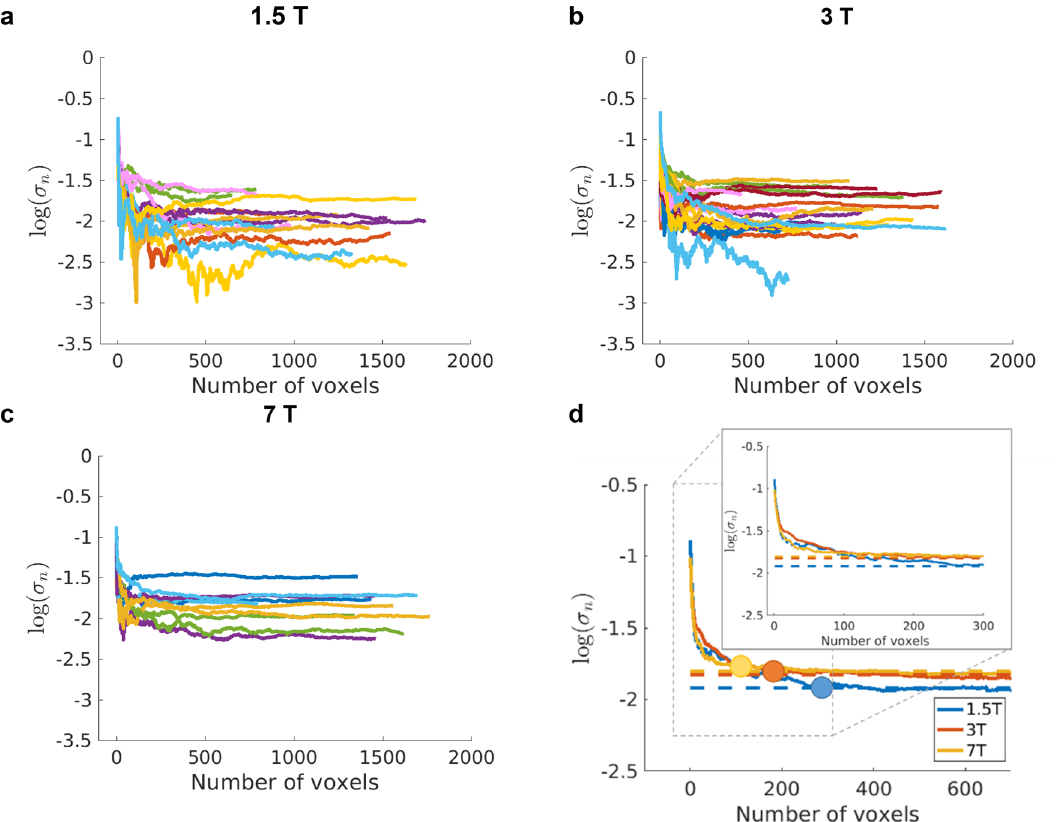
Figure 4. Results of the Weisskoff test: standard deviation over time of the mean resting signal as a function of the number of voxels averaged (see Eq. 1) at 1.5 T, 3 T and 7 T ( a ), ( b ) and ( c ), respectively. The voxels added were located in the middle of the cortex and the curves here correspond to TE = T2* GM at each field. Each colour represents a subject, one line per hemisphere. The differences between the physiological noise levels are not significantly different (p = 0.49) between field strengths. ( d ) The average of the Weisskoff curves over subjects for the three fields studied. The circles correspond to the point in which the curve deviates from the plateau corresponding to the noise level where the physiological noise dominated regime has been reached (dashed lines with same colour-coding as for static field strength). The inset corresponds to the result for the first 300 voxels (without the circles).